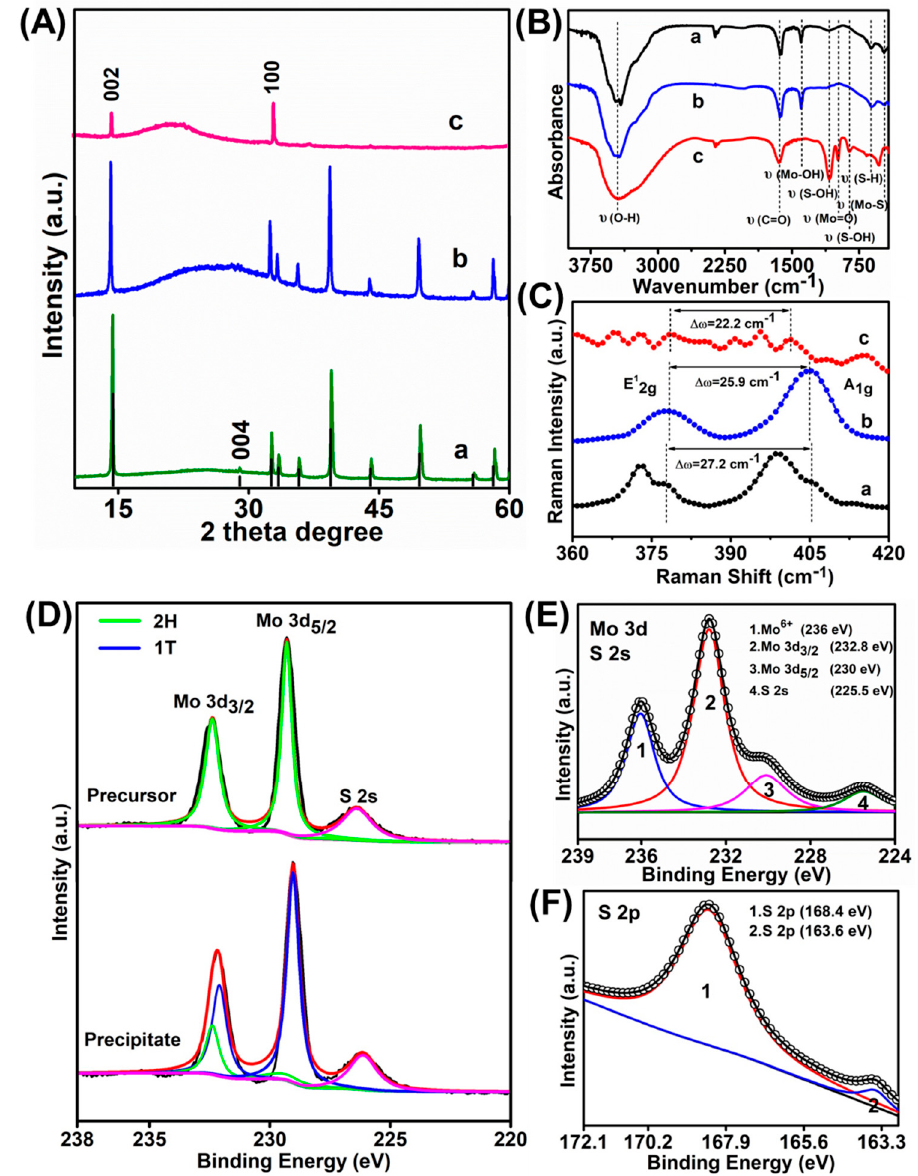
Figure 3. ( A ) XRD patterns, ( B ) FTIR spectra, and ( C ) Raman spectra of a ) MoS 2 precursor, b ) MoS 2 precipitate, c ) MoS 2 QDs, respectively. XPS spectra of the MoS 2 samples: ( D ) narrow scan spectra of Mo 3d of the MoS 2 precursor (above) and the precipitate (below), respectively. ( E ) Mo 3d and ( F ) S 2p peak of the MoS 2 QDs.